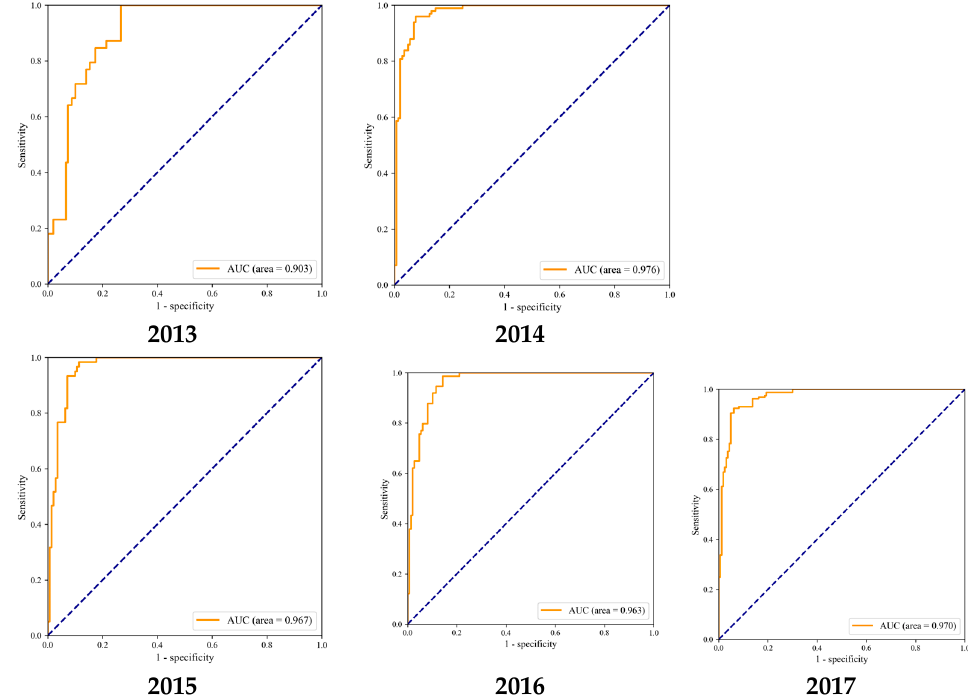
Figure 12. ROC curves of the neural network risk simulation model of H7N9 outbreaks in China from 2013 to 2017. Table 3. Simulation results of the neural network risk simulation model of H7N9 outbreaks in China.